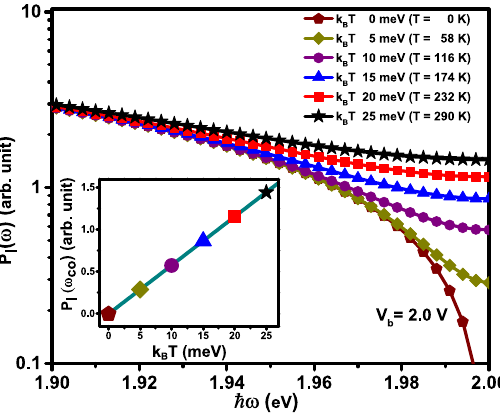
Figure 2. Semi-log plot of energy dependence of P I ( ω ) for biased tunnel junction for various k B T (inset: temperature variation of P I ( ω co ) at ħ ω co = 2 eV).